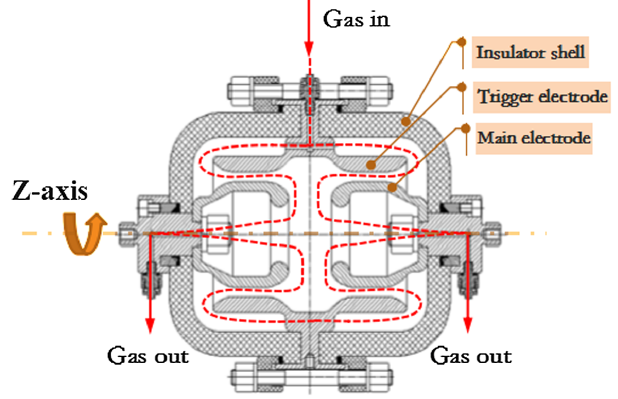
FIG. 7. The configuration of long-life gas spark-gap switch.